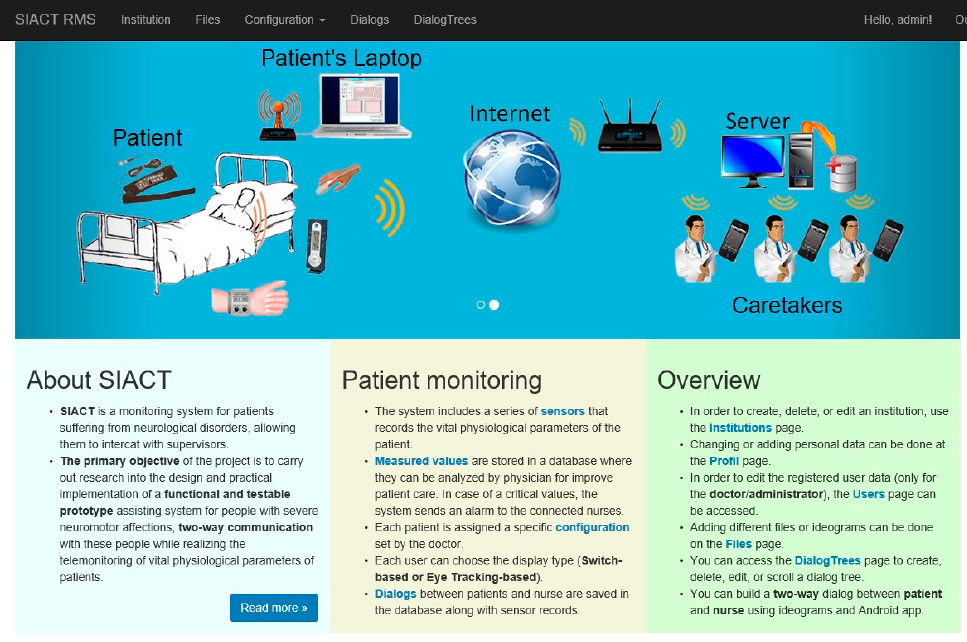
Figure 14. Homepage of the Patient WEB Application.